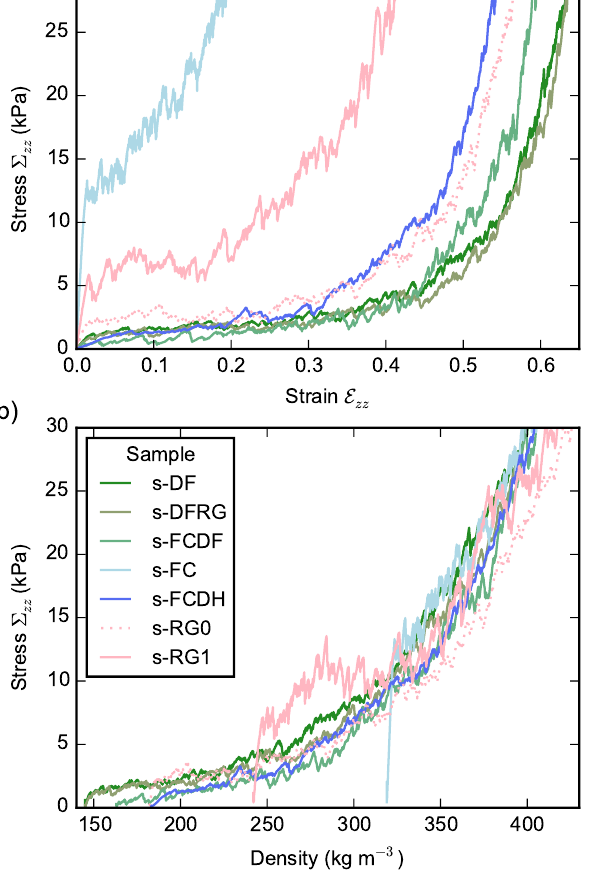
Figure 11. Simulated stress–strain curves (a) and stress–density re- lation (b) for the different snow samples (Table 1). The legend is the same for (a) and (b)